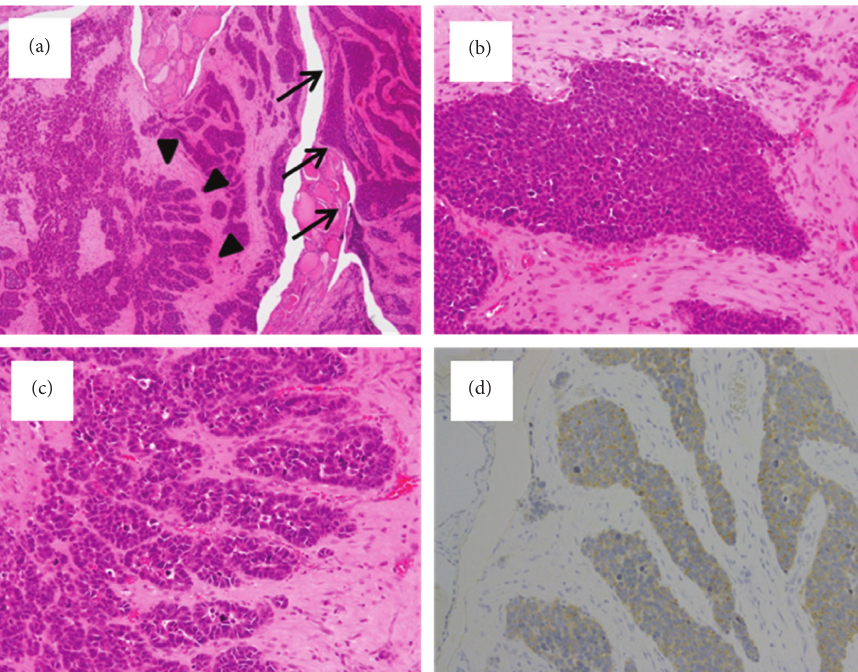
Figure 2: Histopathological and immunohistochemical findings of the thyroid tumor following the thyroidectomy. (A) The tumor consists of two distinct areas: a small-cell carcinoma indicated by arrows and a large-cell carcinoma shown by arrow heads (H&E staining at low power). (B) Half of thetumorshowssolidgrowthofsmallcellswithround-to-ovalnucleiandscantcytoplasm,consistentwithsmall-cellcarcinoma(H&Estainingathigh power). (C) The other half shows nests and rosettes of polygonal cells with enlarged round-to-oval and prominent nuclei, consistent with large-cell carcinoma (H&E staining at high power). (D) Immunohistochemistry revealed positive staining for synaptophysin in the overall tumor at low power.